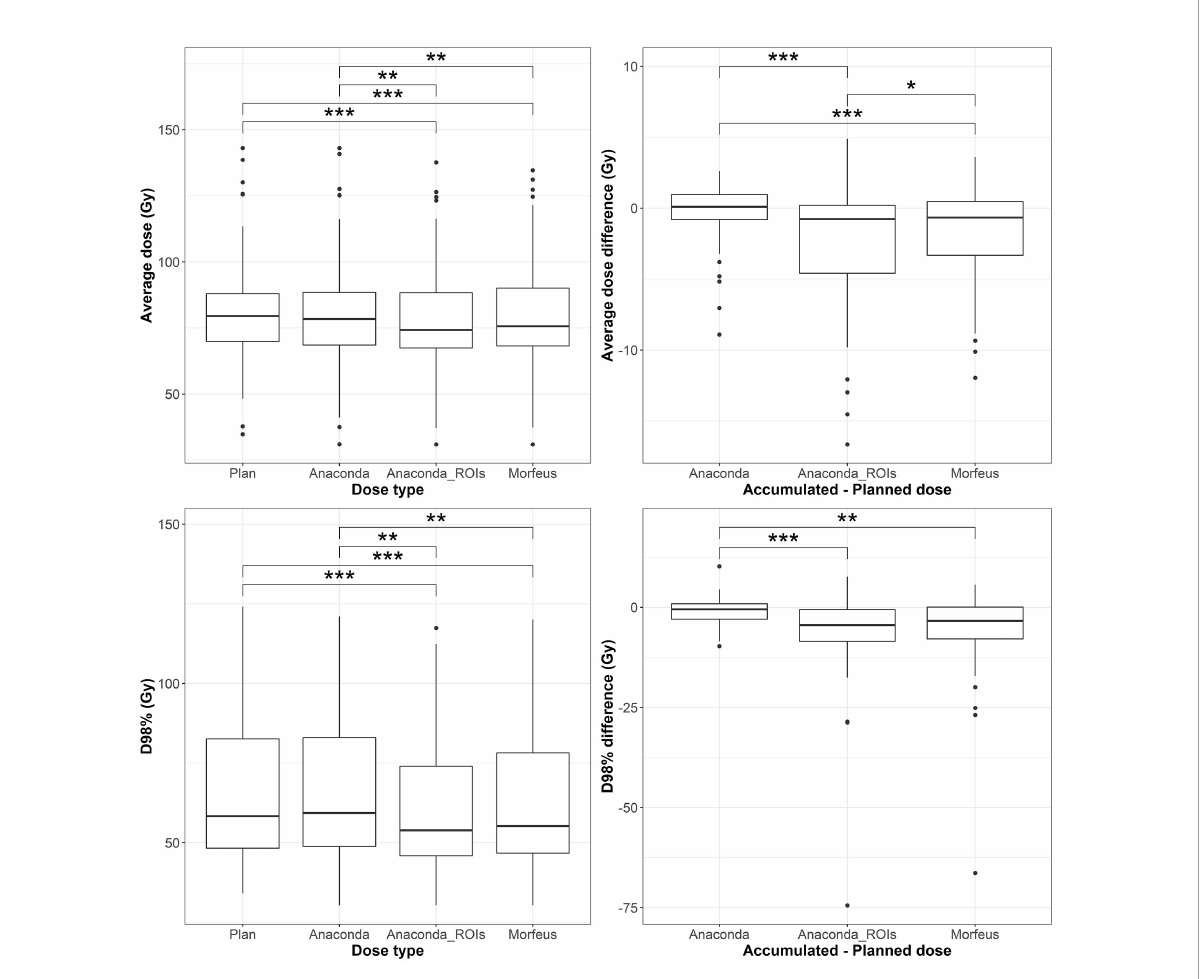
FIGURE 3 Left: average (top row) and maximum (bottow row) planned and accumulated GTV EQD2 (Gy). Right: difference between accumulated and planned doses. Statistically signi fi cant differences between means are indicated according to Bonferroni-adjusted p-values (*p <0.05; **p <0.01; ***p